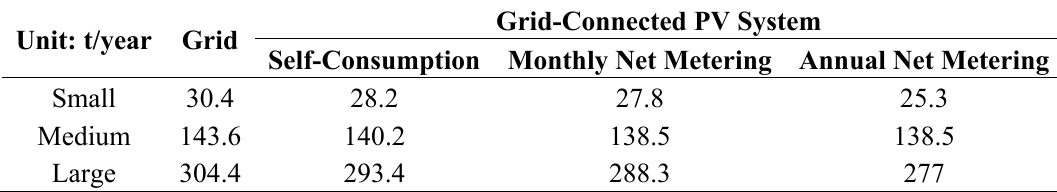
Table 11. Equivalent CO 2 for electrical power grid and grid-connected PV